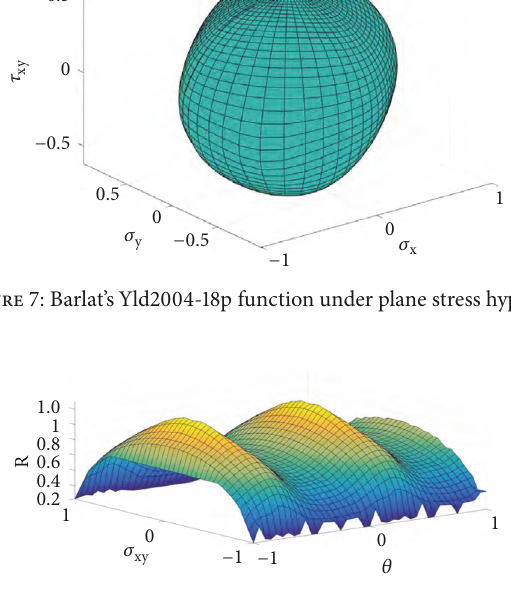
Figure 8: 𝑅(𝜃,𝜎 𝑥𝑦 ) function for Barlat’sYld2004-18p yield